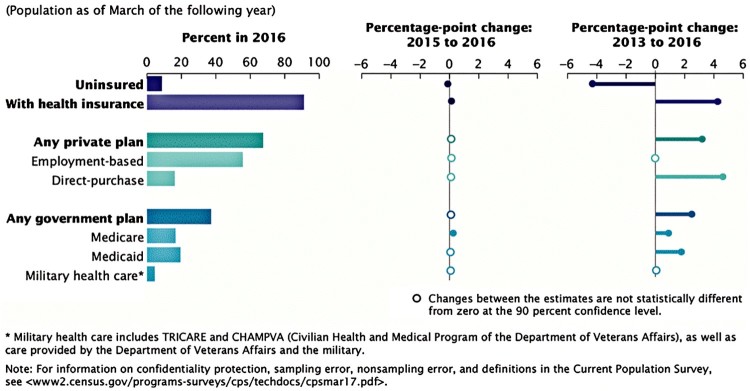
Percentage of people by type of health insurance coverage and change from 2013 to 2016Source: US Census Bureau, 2017.